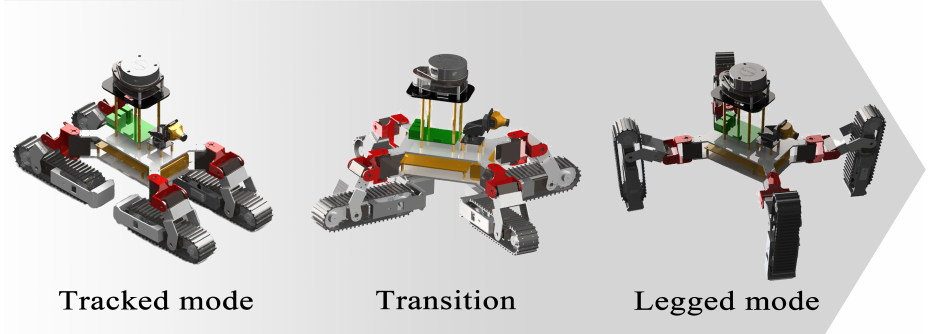
Figure 4. The transition process.